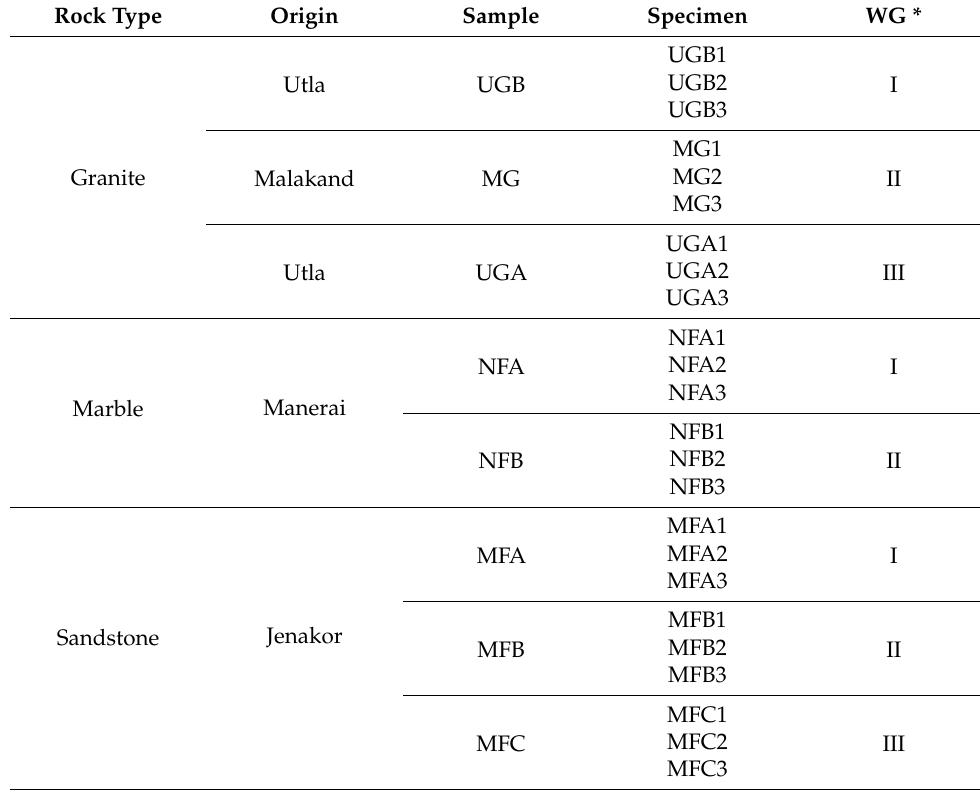
Table 2. List of abbreviations and acronyms used in this